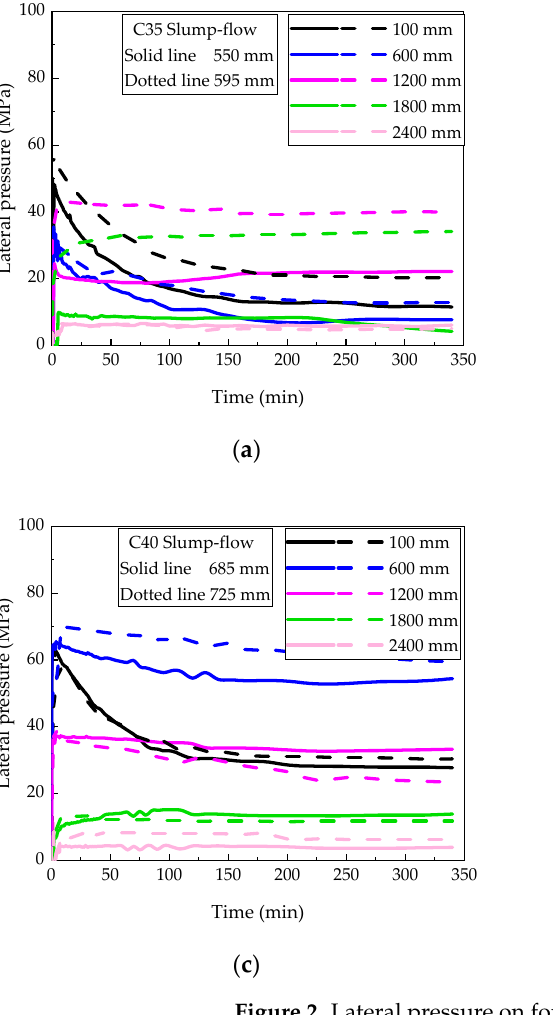
Figure 1. Lateral pressure test arrangement of vertical joint: ( a ) vertical joint formwork; ( b ) ar- rangement of measuring cells (unit: mm); ( c ) casting of SCC.